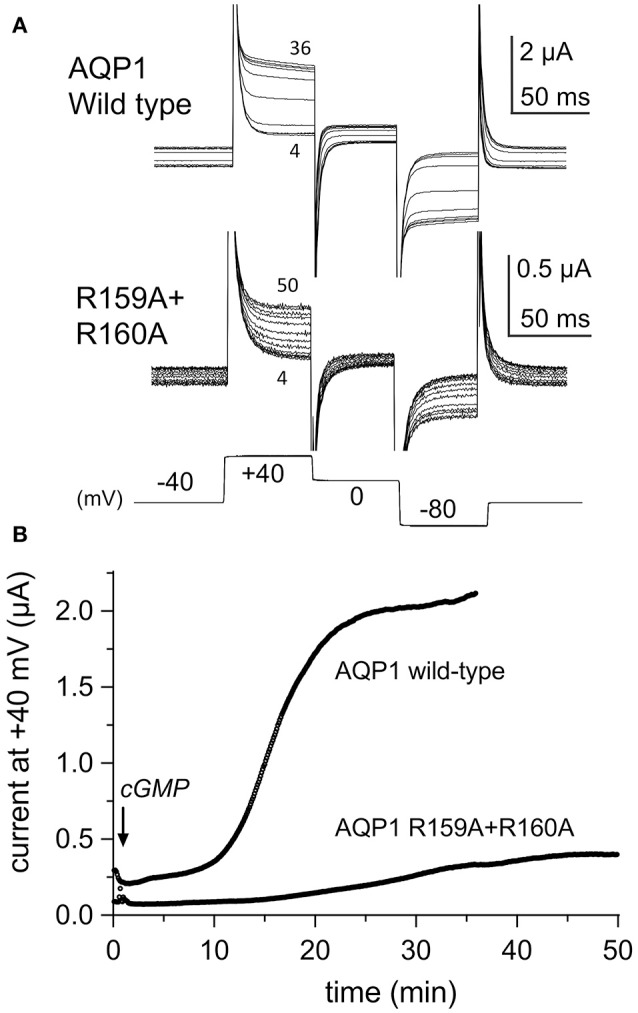
Rates of activation of ion conductance responses to CPT-cGMP in oocytes expressing AQP1 wild type or R159A+R160A channels. (A) Ion current responses were monitored after application of CPT-cGMP using repeated series of brief steps to +40, 0, and −80 mV from a holding potential of −40 mV (10 per minute; 150 ms each). Traces are shown at 4 min intervals for clarity. Numbers indicate time in minutes post-application of CPT-cGMP. (B) The plot of steady state current amplitudes at +40 mV as a function of time after application of CPT-cGMP at time zero illustrates the difference in latency to activation in representative examples of AQP1 wild type and R159A+R160A expressing oocytes.